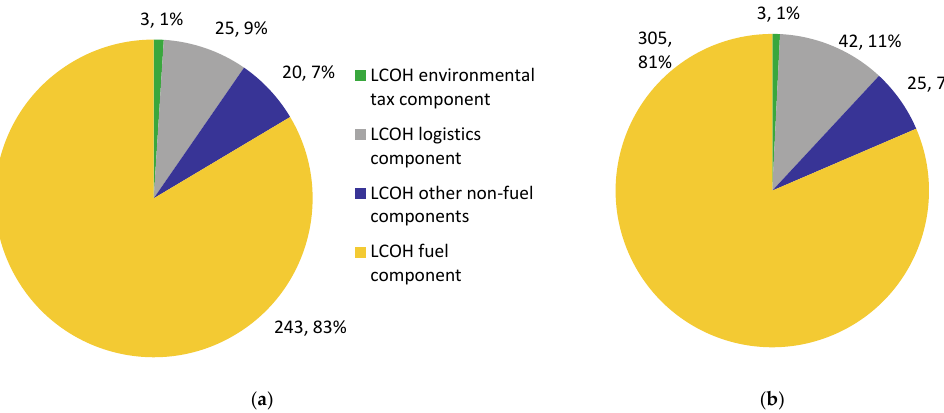
Figure 5. LCOH structure from KZOT BRS 1000 Comfort BM (1 MW) from sunflower husk pellets: ( a ) January 2022; ( b ) July 2022.